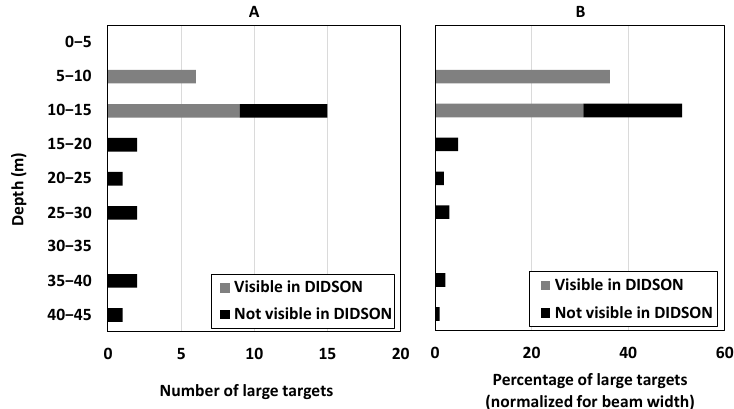
0.0−0.5 0.5−1.0 Current Velocity (m∙s ‐1 ) Figure 6. Distribution of current speeds at the time of occurrence for all large targets detected in Western Passage. Gray indicates those that were visible in the DIDSON and black indicates those that were not visible in the DIDSON. Vertical dashed line indicates the speed at which an assumed tidal turbine would begin to rotate (1 m · s − 1 ) based on depth-averaged current velocity from ADCP data. J. Mar. Sci. Eng. 2020 , 8 , x FOR PEER REVIEW